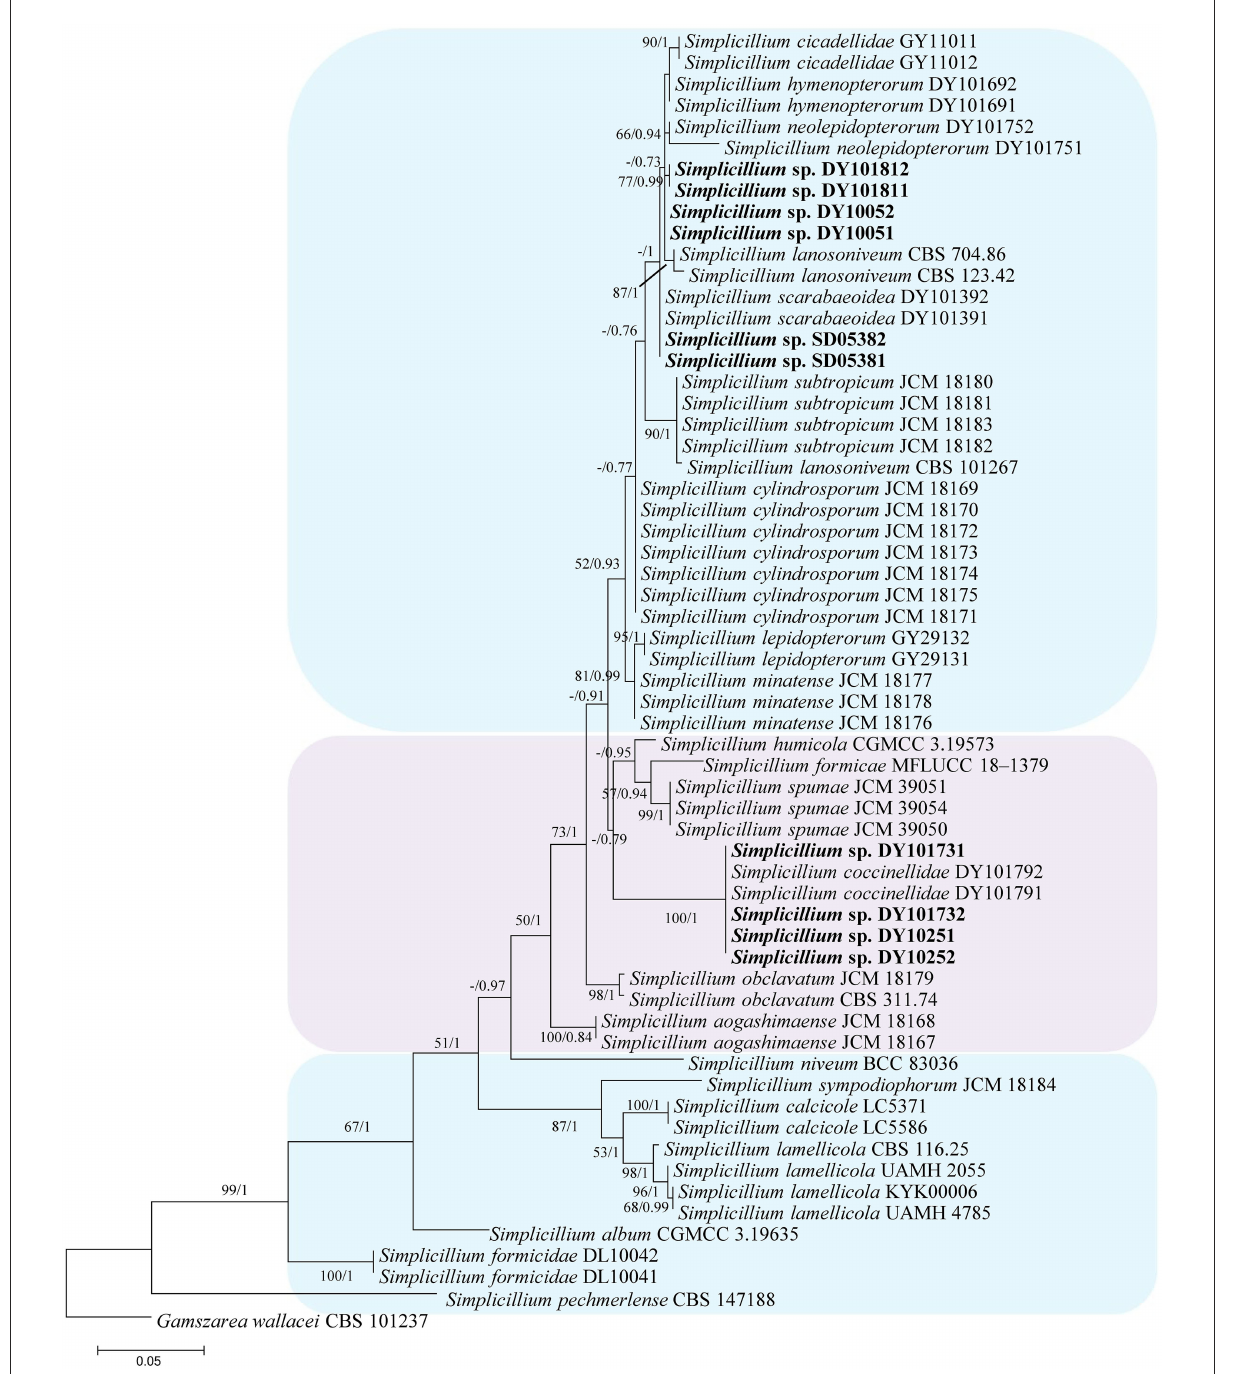
FIGURE1 Phylogenetic identification of the new strains in the genus Simplicillium based on ITS sequence. Statistical support values ( ≥ 0.5/50%) are shown at the nodes for ML bootstrap support/BI posterior probabilities.